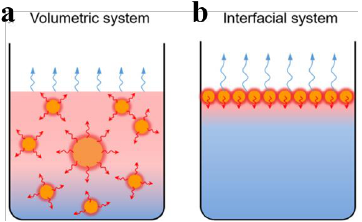
Figure 1: Schematic drawing of two photothermal evaporation systems: (a) the volumetric system and (b) the interfacial system